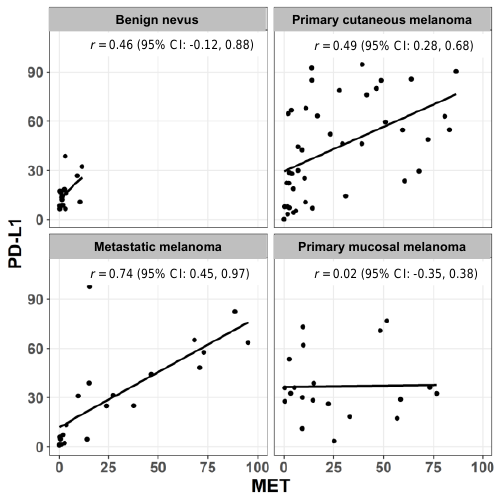
Figure 3. Correlation of MET and PD-L1 in benign nevi, primary cutaneous melanoma, metastatic melanoma, and primary mucosal melanoma, with Pearson’s r values and 95% confidence interval .